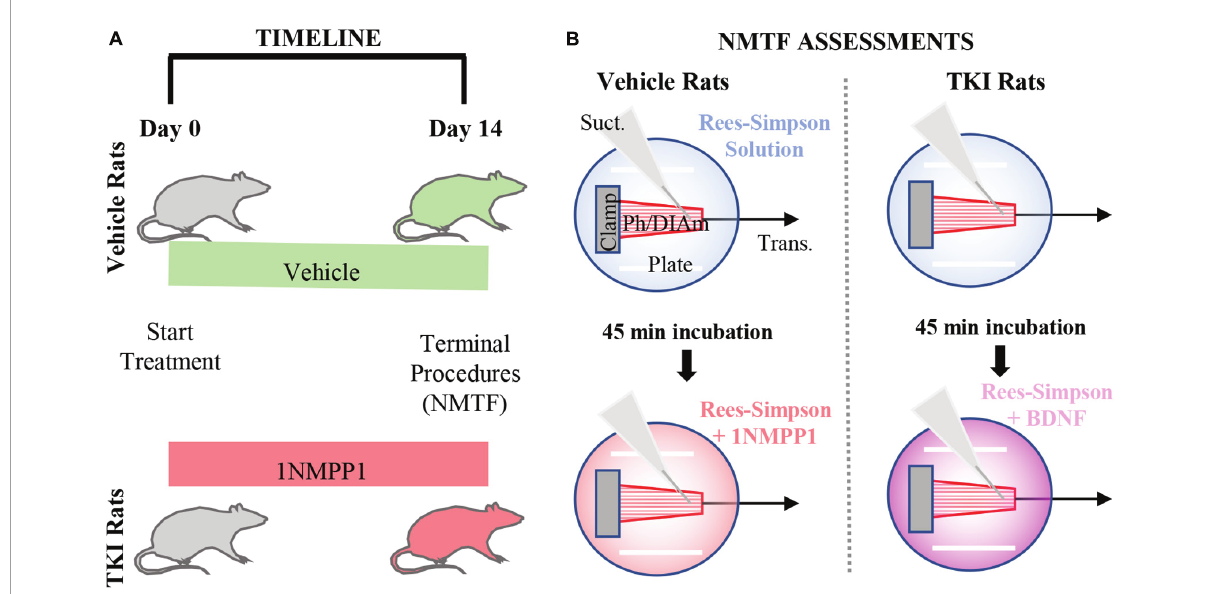
FIGURE1 Experimental design and neuromuscular transmission failure (NMTF) assessment approach. (A) Timeline shows the order of the experiments, with vehicle and TKI groups randomly separated at day 0, when treatment with vehicle or 1NMPP1 commences. At day 14, terminal procedures (NMTF) are performed. (B) The NMTF assessment diagram shows the experimental setup of the Bulbring DIAm-phrenic nerve preparation (Ph/DIAm) clamped (Clamp) at the rib end and attached via suture to the transducer ( Trans. ). A suction electrode (Suct.) and platinum plate electrodes (Plate) stimulate the nerve and muscle, respectively. In both vehicle and TKI rats, NMTF is performed at 24 ◦ C in Rees-Simpson solution (transparent blue) bubbled with carbogen gas. Following the first NMTF trial, Ph/DIAm preps are pre-incubated for 45 min in either